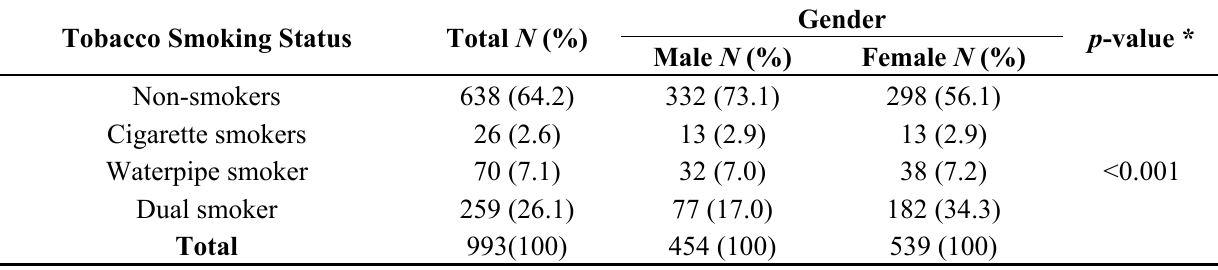
Table 2. Association between participants’ gender and tobacco smoking status. Tobacco Smoking Status